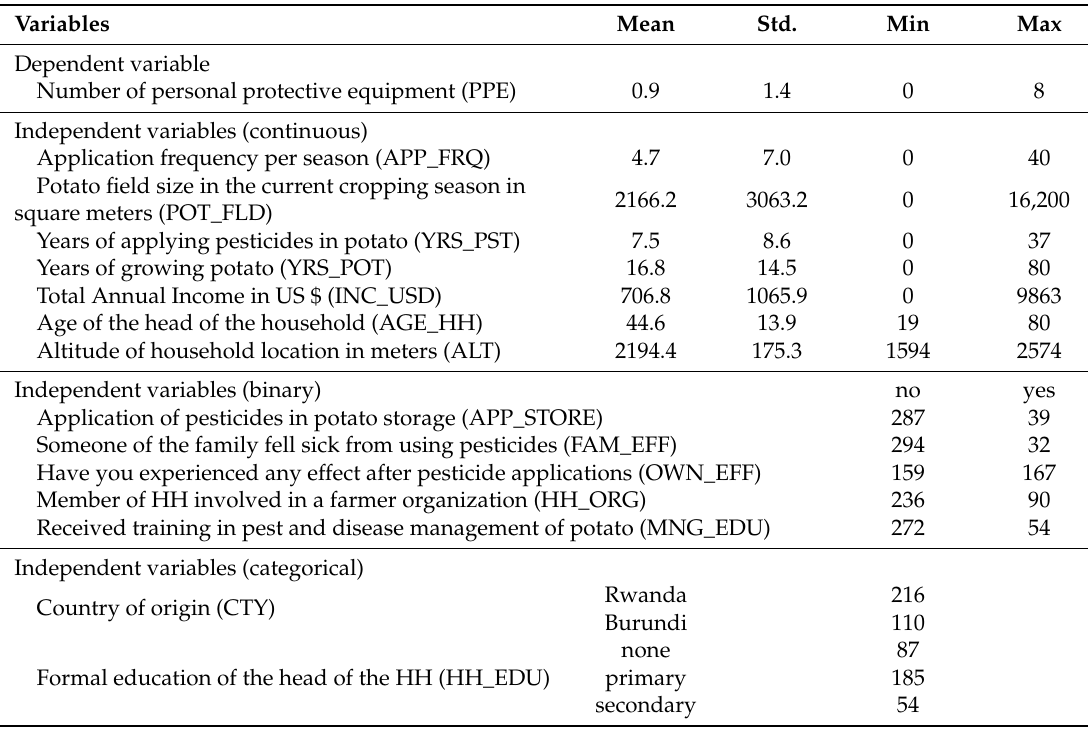
Table 2. Descriptive statistics for the variables used in the regression